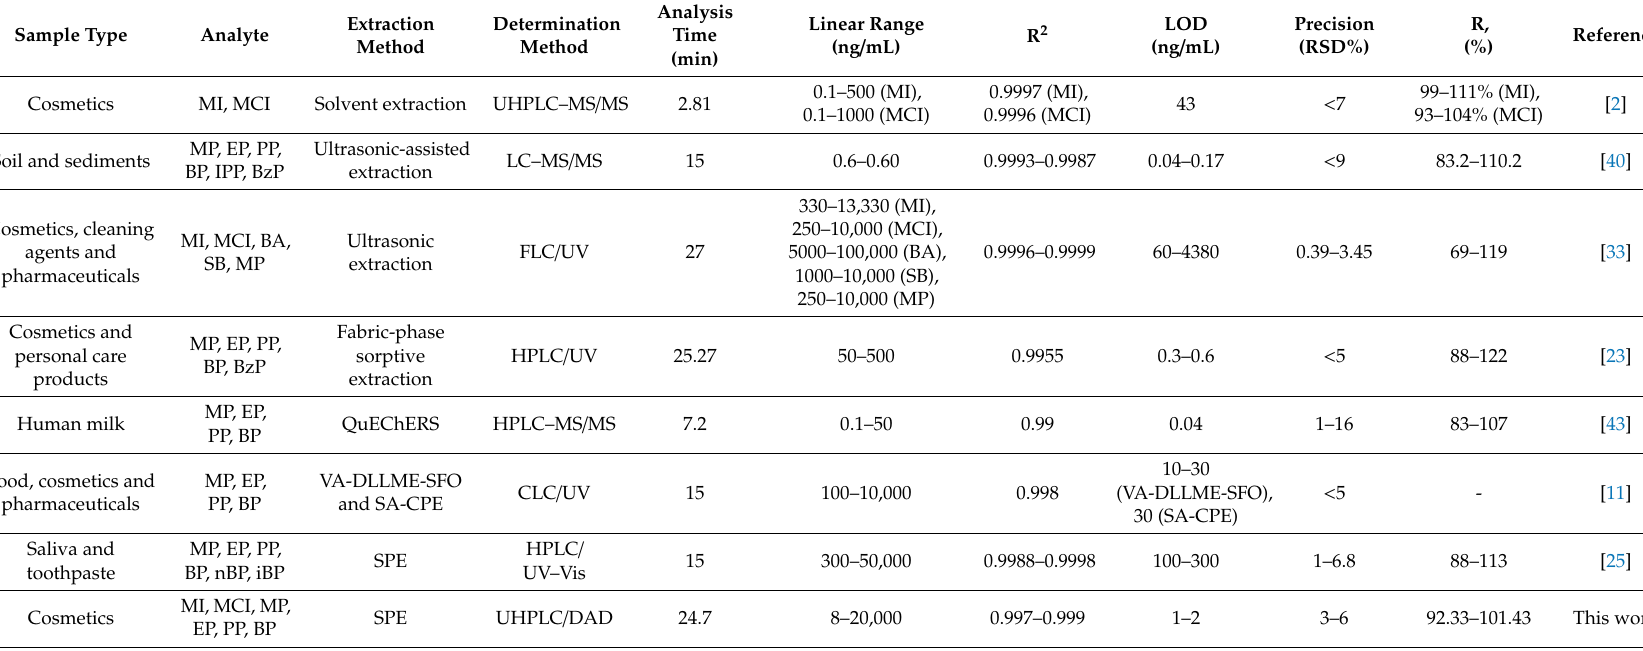
Table 3. Comparison of the proposed method with earlier developed